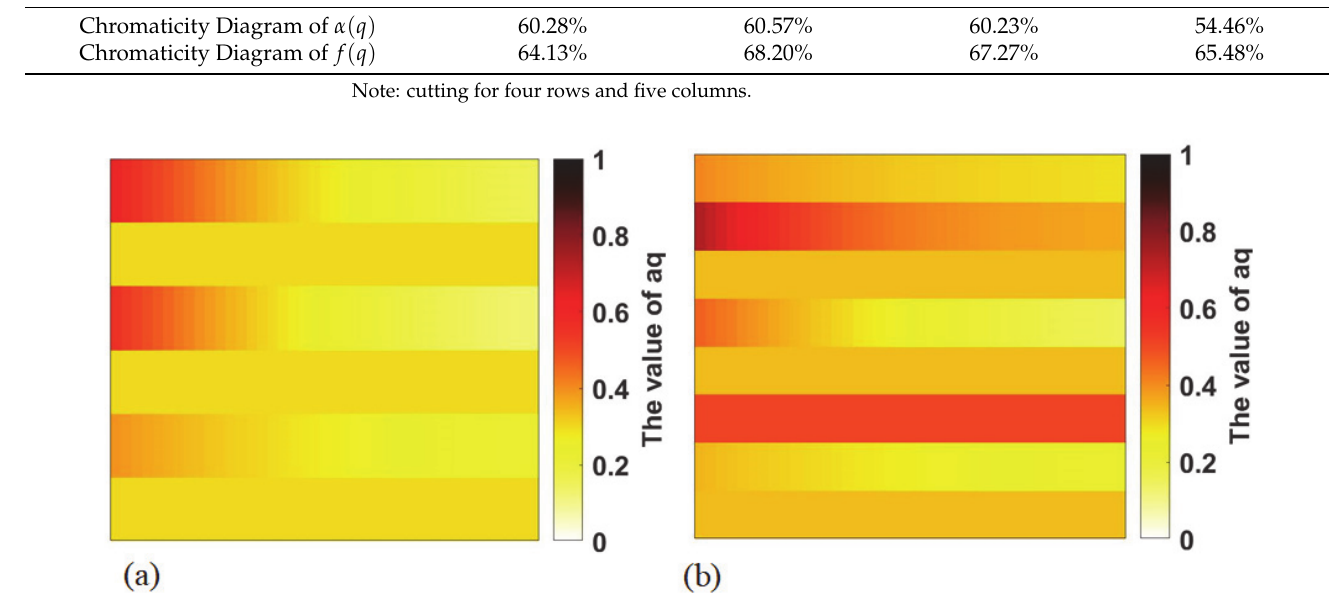
Table 1. Input the chromaticity diagram into the model and obtain the test set recognition rate under different training rounds and learning rates.